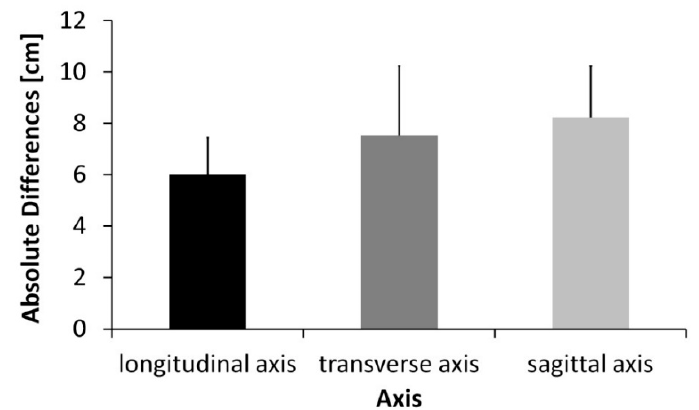
Figure 6. Means and standard deviations of absolute differences for the three axes. Longitudinal axis corresponds to x -axis, transverse axis to y -axis and sagittal axis to z -axis in Figure 1.